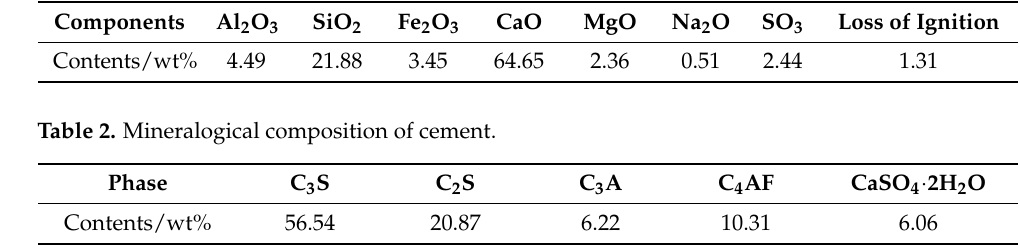
Table 1. Chemical compositions of cement.